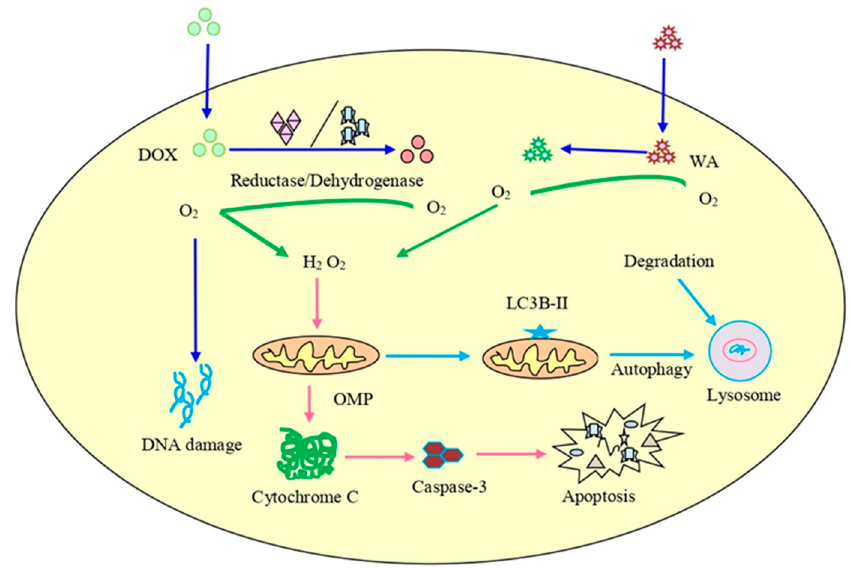
Figure 4. The combined treatment of doxorubicin (DOX) and withaferin A on cancer cells. It can lead to enhanced ROS production, destruction of DNA, initiation of autophagy, and increased expression of LC3B autophagy marker as well as cleavage of caspase-3.